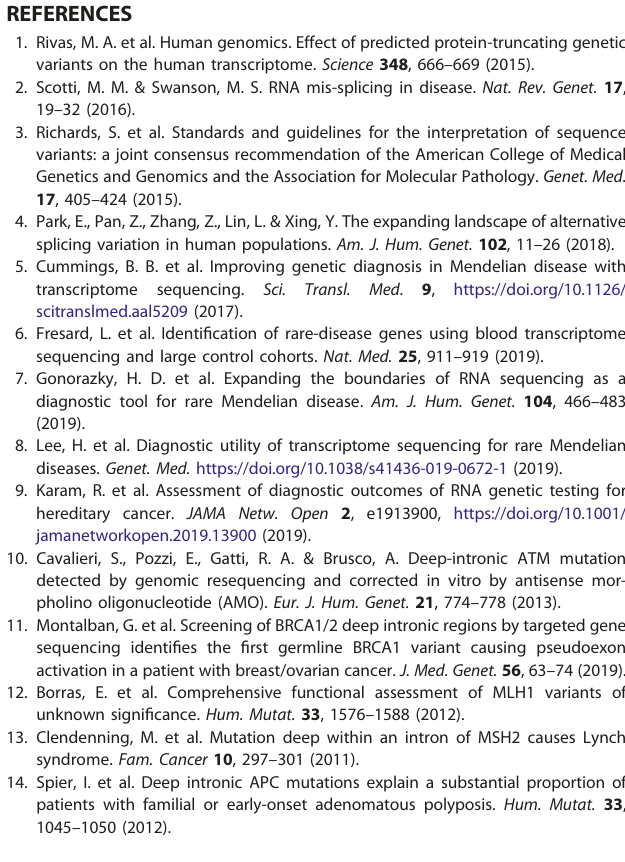
Fig. 4 Pathogenic variants identi fi ed in a consecutive cohort of 1000 patients analyzed by paired DNA and RNA genetic testing. All PSI values shown were signi fi cantly higher than the mean control PSI (one-sample two-sided t test, p < 1 × 10 − 55 ). a PSI for variant-associated r dot, shown in red, compared to boxplot representing median and interquartile range of PSI for healthy controls, if applicable (outlier points are not shown). b Sashimi plot of BRCA1 r.80_81ins81-8_81-1 indicating coverage and junction reads supporting the 8 bp partial intronic insertion. Patient plot is tuna-colored, whereas control plot is salmon colored. c Sashimi plot of BRCA1 r.5075_5152del indicating coverage and junction reads supporting the coding exon 16 skipping. d Sashimi plot of BRCA2 r.426_475del indicating coverage and junction reads supporting the coding exon 4 skipping. e Sashimi plot of ATM r.8269_8418del indicating coverage and junction reads supporting the coding exon 56 skipping. f Sashimi plot of ATM r.3061_3077del indicating coverage and junction reads supporting the partial skipping of coding exon 19. g Sashimi plot of MUTYH r.576_577ins577-4_577-1 indicating coverage and junction reads supporting the partial intron 7 retention. h Sashimi plot of PMS2 r.11_23del indicating coverage and junction reads supporting the partial skipping of coding exon